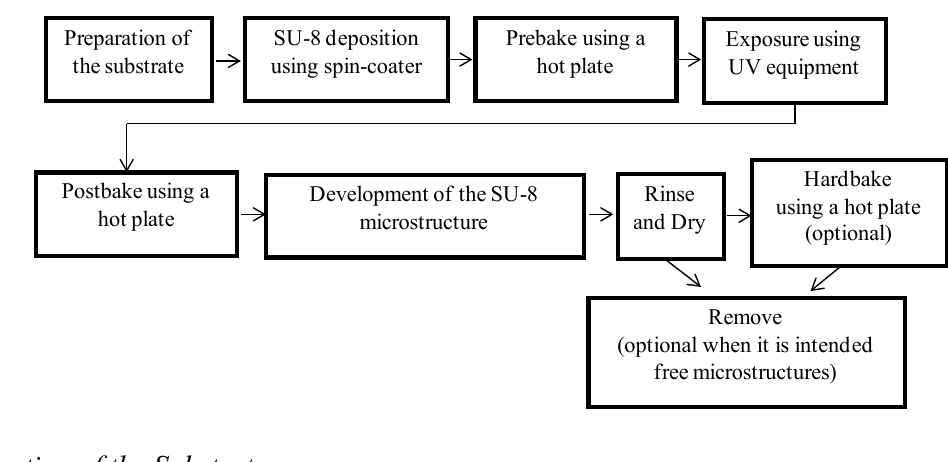
Figure 1. Basic steps of the epoxy-based negative photoresist (SU-8) processing with low-cost and without cleanroom